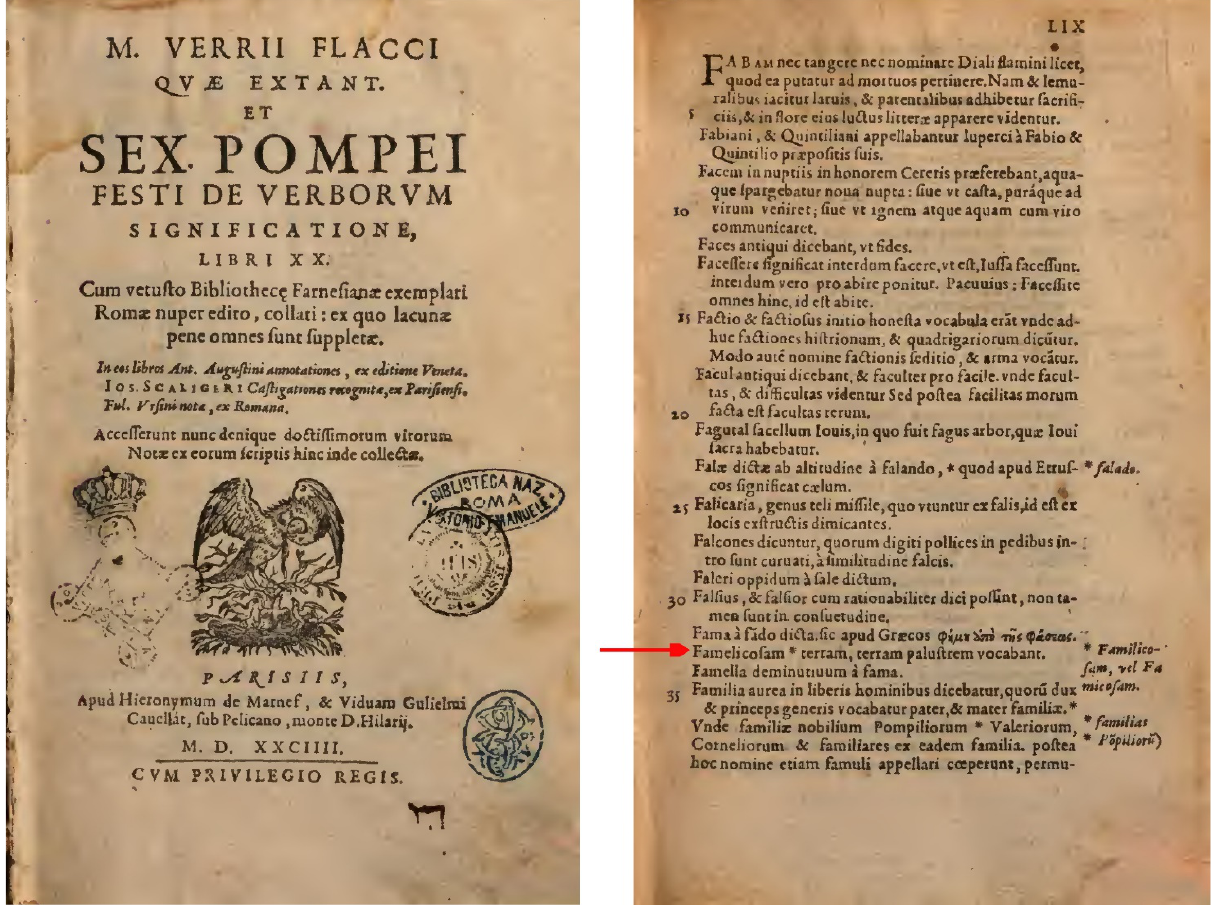
Figure 3. Title page of the 1584 edition of ‘De verborum significatione’, and the page with the entry “famelicosam * terram, terram palustrem vocabant * familicosam, vel